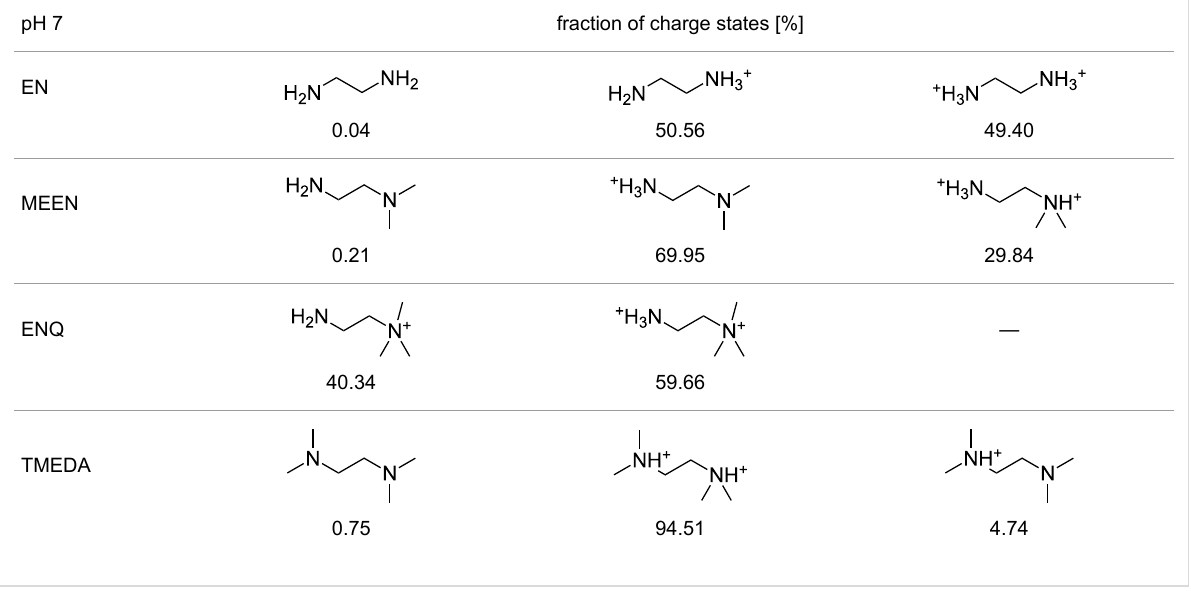
Table 1: Diamines used in the turbidity measurements and their calculated fractions of the charge states at pH 7. pH 7